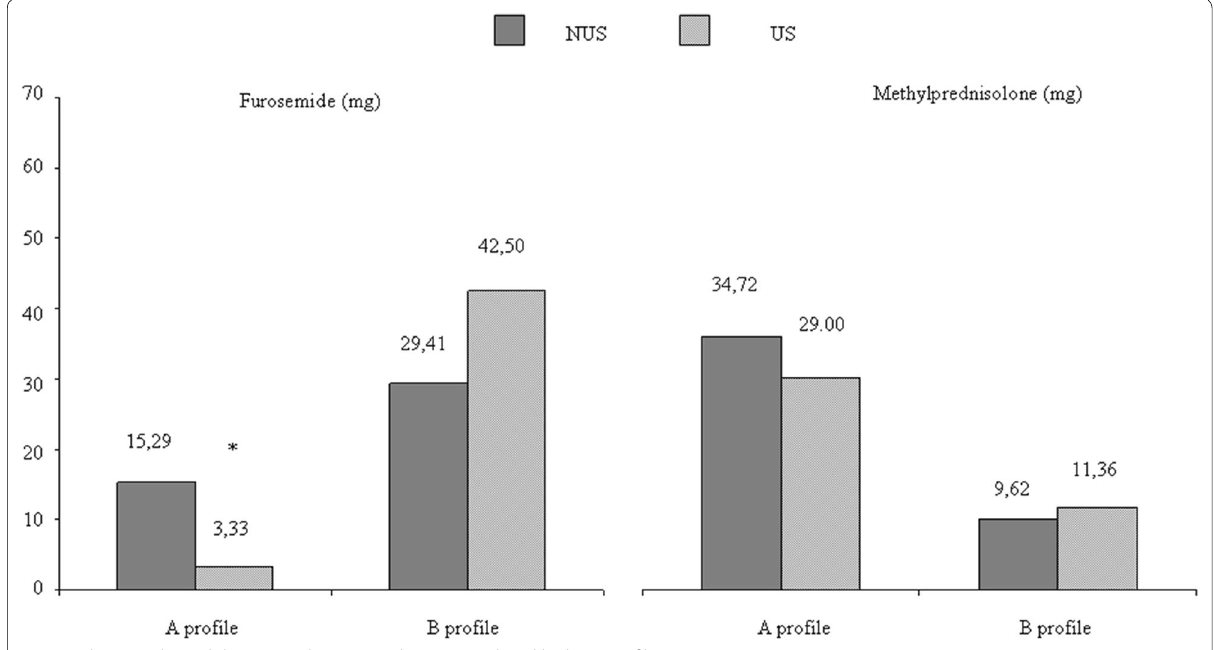
Fig. 1 Pharmacological therapy in the two study groups splitted by lung profile